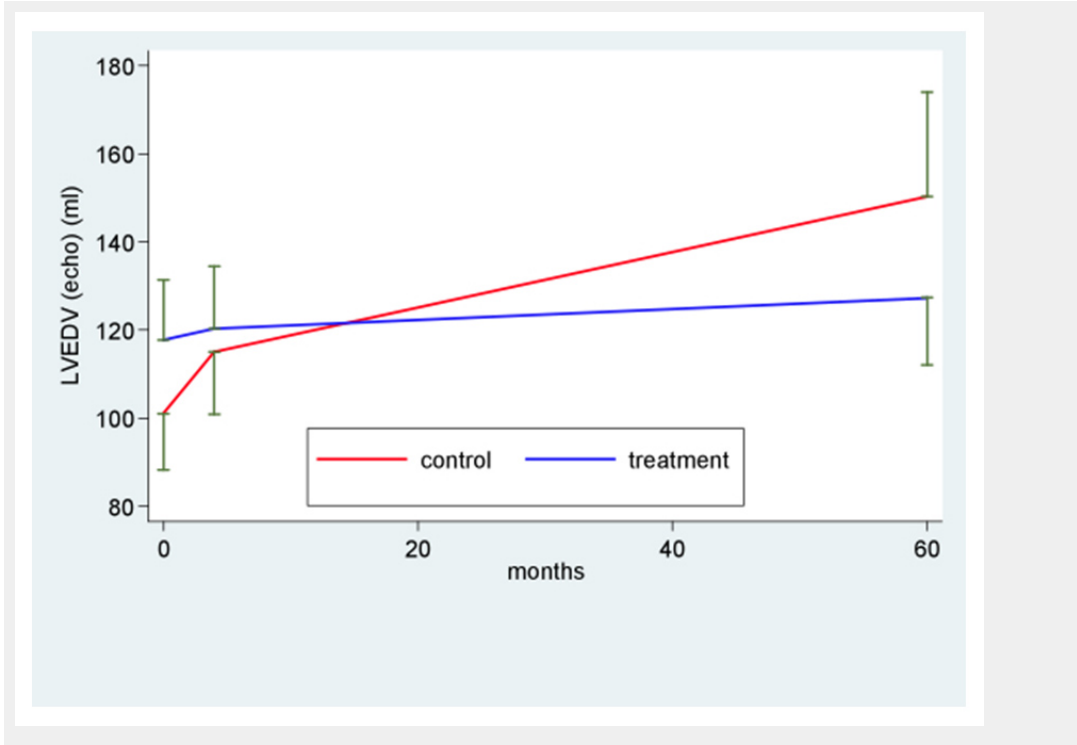
Figure 3 Left ventricular remodelling directly after myocardial infarction (baseline), after 4 and 60 months. LVEDV: left ventricular enddiastolic